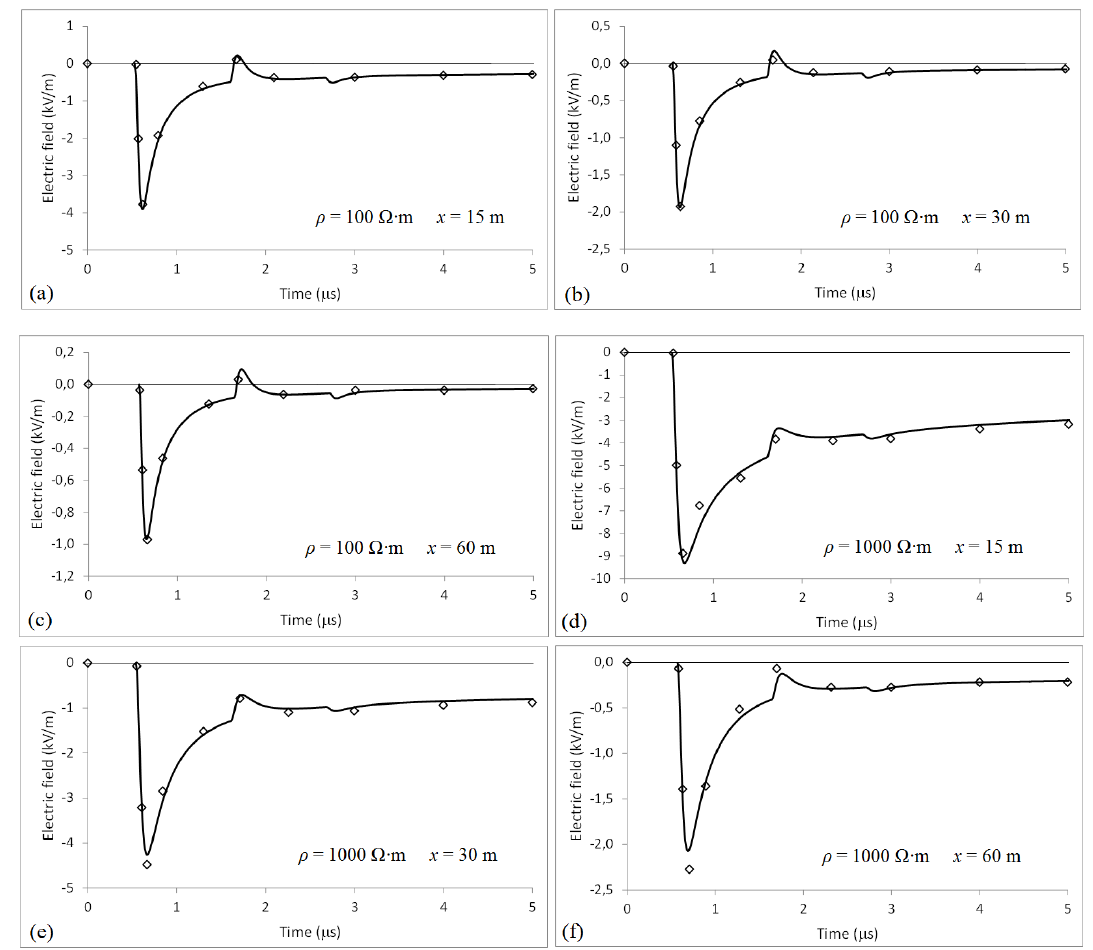
Figure 5. Horizontal electric field at the ground surface for different values of ground resistivity ( ρ ) Figure 5 . Horizontal electric field at the ground surface for different values of ground resistivity ( ρ ) and distance from the structure axis ( x ). Solid line: analytical Equation (4); Dots: extracted from [2]. and distance from the structure axis ( x ). Solid line: analytical Equation (4); Dots: extracted from [2]. ( a ) ρ = 100 Ω · m; x = 15 m; ( b ) ρ = 100 Ω · m; x = 30 m; ( c ) ρ = 100 Ω · m; x = 60 m; ( d ) ρ = 1000 Ω · m; ( a ) ρ = 100 Ω∙m; x = 15 m; ( b ) ρ = 100 Ω∙m; x = 30 m; ( c ) ρ = 100 Ω∙m; x = 60 m; ( d ) ρ = 1000 Ω∙m; x = 15 m; x = 15 m; ( e ) ρ = 1000 Ω · m; x = 30 m; ( f ) ρ = 1000 Ω · m; x = 60 (e ) ρ = 1000 Ω∙m; x = 30 m; ( f ) ρ = 1000 Ω∙m; x = 60 m.